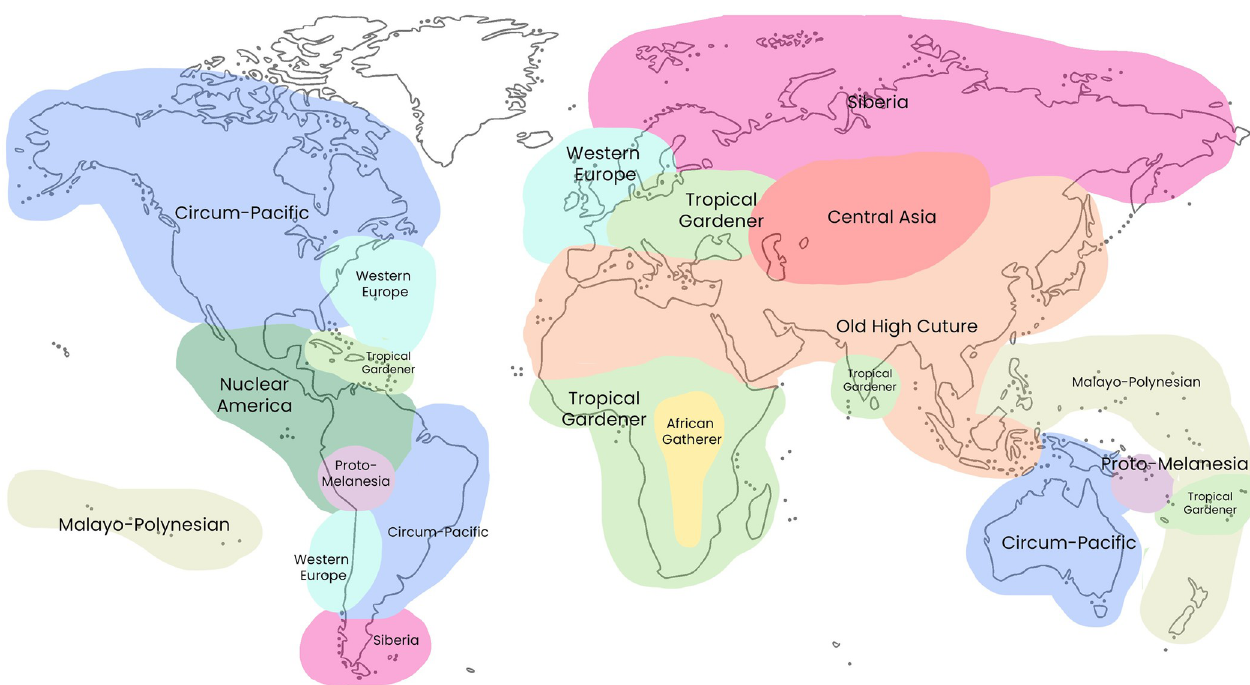
Fig 1. Global map of 10 song-style regions previously identified by factor analyses of Cantometrics data (adapted from [15]). Lomax and Arensberg’s novel methods, execution, and conclusions drew considerable criticism when they were published and subsequently (e.g., [31–36]; cf. [14,17,18]for review and discussion). One major impediment to overcoming criticism was that the raw Cantometric data and sample were never made public for others to examine and reanalyze. The public release of the Global Jukebox now largely solves this problem.